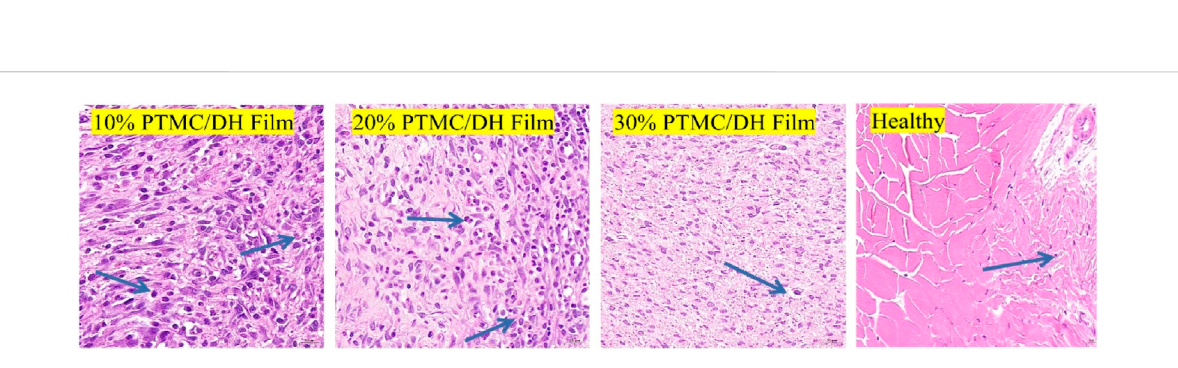
FIGURE 11 Intercepted fi eld of view images of fi broblast density after 4 weeks of treatment (Blue arrows show fi broblast